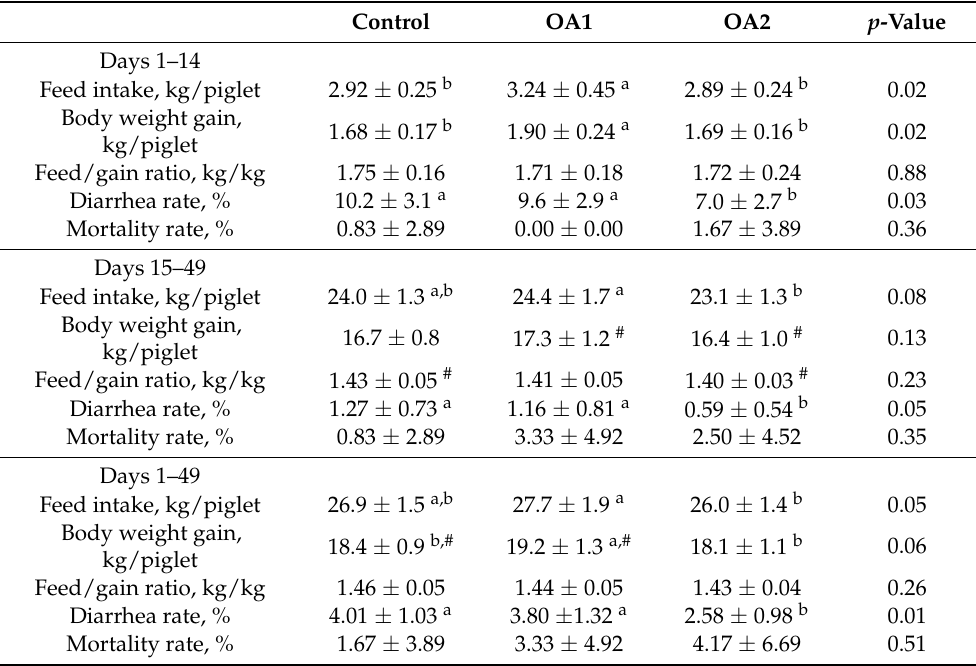
Table 1. Effects of organic acids on growth performance and diarrhea rate 1